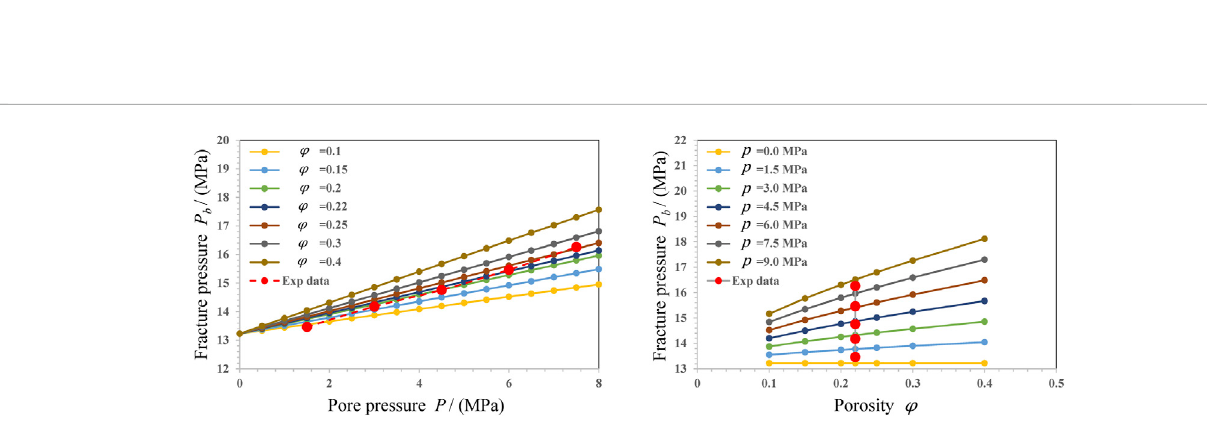
Frontiers in Earth